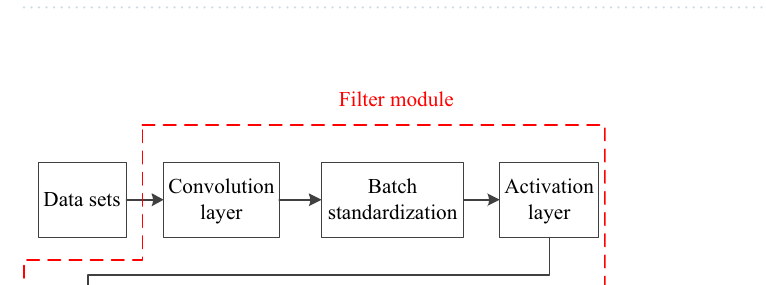
Table 2. Actuator fault type table.